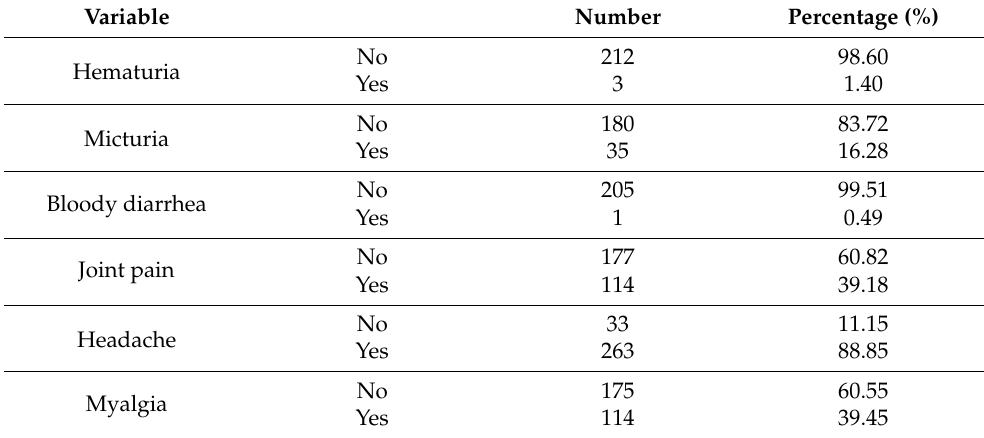
Table 3. Clinical characteristics of enrolled febrile adults in Mwanza.